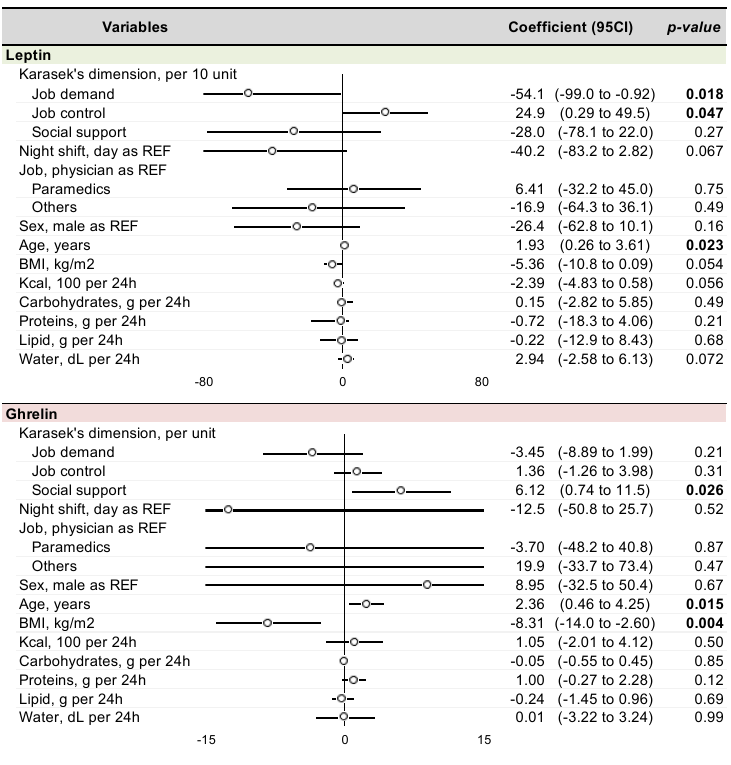
Figure 3. Impact of stress assessed using Karasek jobdemand-control-suport, night, sociodemo- graphic status and nutrition on leptin and ghrelin salivary levels using a linear mixed model. Job demand refers to the psychological needs imposed by daily working activities, job control refers to the latitude of decision and is composed of two components: skill discretion and decision authority. Social support represents the support from colleagues and/or from the hierarchy. Results were ex- pressed using coefficient regression (95% confidence interval). Results were considered significant for p -value < 0.05 and 95 CI not containing 0. BMI = body mass index, kg = kilogram, m 2 = square meter, g = gram, dL = deciliter.